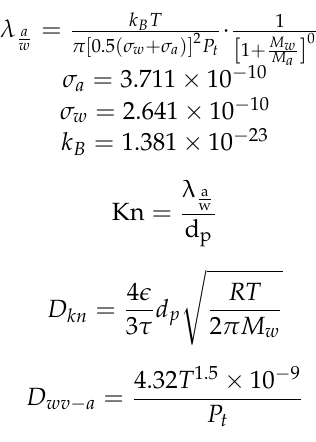
Figure S7. (A) Downstream variation of membrane temperature difference between feed-side and permeate-side for different channel length. (B) Variation of membrane temperature difference between feed-side and permeate-side with varying channel length. (C) Variation of membrane vapour pressure difference between feed-side and permeate-side with varying channel length. Figure S8. (A) Mean membrane temperature difference between feed-side and permeate-side for 22 different available commercial membranes listed in Table 2. (B) Mean membrane vapour pressure difference between feed-side and permeate-side for 22 different available commercial membranes listed in Table